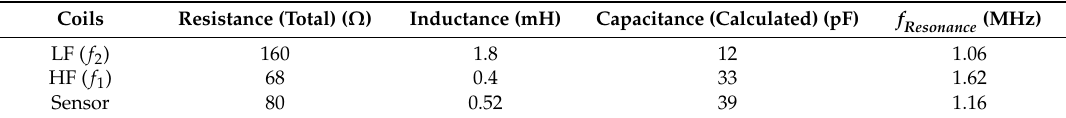
Table 1. Electrical parameters values for two different prototypes of realized Printed Circuit Board (PCB) multilayer coils. The capacitance was deduced from the